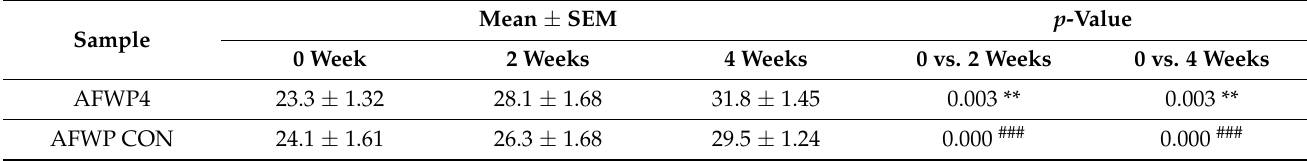
Table 2. Effects of AFWP on skin moisture content ( n =